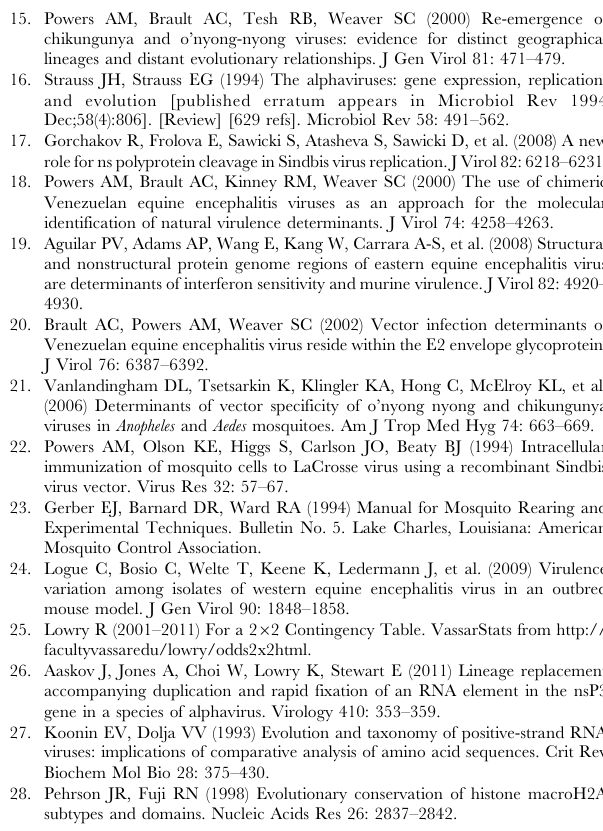
Figure S1 Illustration of exact nsP3 substitution made to create CHIK/ONN nsP3. Figure S2 Construction of CHIKV nsP3 receiving plas- mid. PCR primers were designed to generate two amplicons flanking the DNA insertion sites and extend outward to include unique restriction enzyme sites and inward to include a unique type II restriction site. Amplification with these primers, subsequent digestion with PciI/SacI or EcoRI/SacI, followed by a 3-part ligation produce a pUC-based vector containing CHIKV sequence flanking the site where ONNV nsP3 will later be inserted. Figure S3 Amplifying ONNV nsP3. PCR primers were designed to amplify the desired DNA insert, with the addition of type II restriction enzyme sites to the termini. Type II sites were oriented such that they will be removed upon later digestion. Figure S4 Expanded sequence of assembled CHIKV nsP3 receiving plasmid (top). Termini of ONNV nsP3 amplicon (bottom). The lines indicate the cut sites for the type II restriction enzymes.